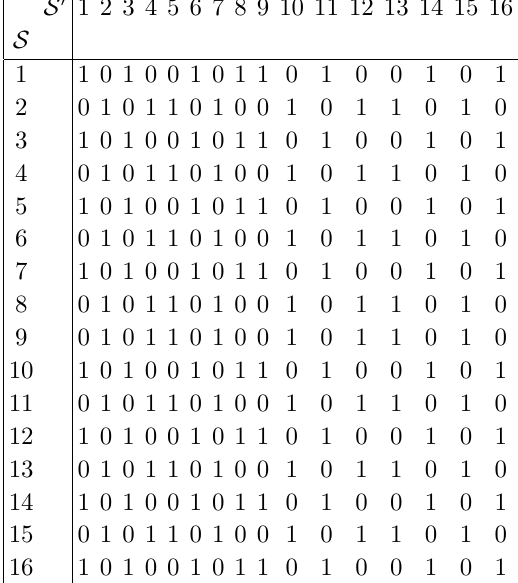
(cid:2) P with di(cid:11)erent boolean factors. [1] [4]